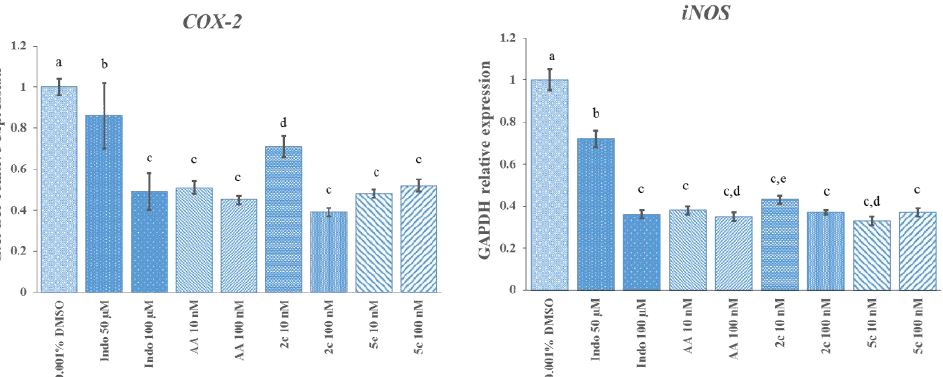
Figure 5. Effects of ascorbic acid, compound 2c , and compound 5c at 10 and 100 nM, on mRNA expression levels of COX -2 (cyclooxygenase-2) and iNOS (inducible nitric oxide synthase) genes in LPS inflammatory-activated RAW 264.7 macrophages. Each bar is presented as mean ± SD ( n = 3). Different letters (a, b, c, d, and e) indicate significant differences of means between the groups ( p -value < 0.05) based on Tukey’s HSD one-way ANOVA using PAST version 3.14, Oslo, Norway.